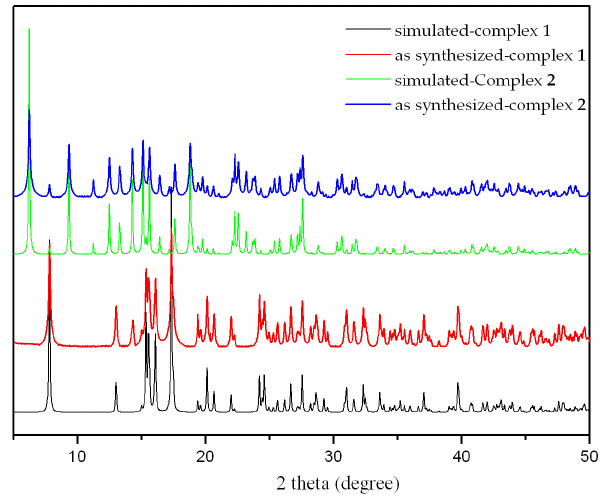
Figure 8. The X-ray powder diffraction of the complexe s 1 and 2.